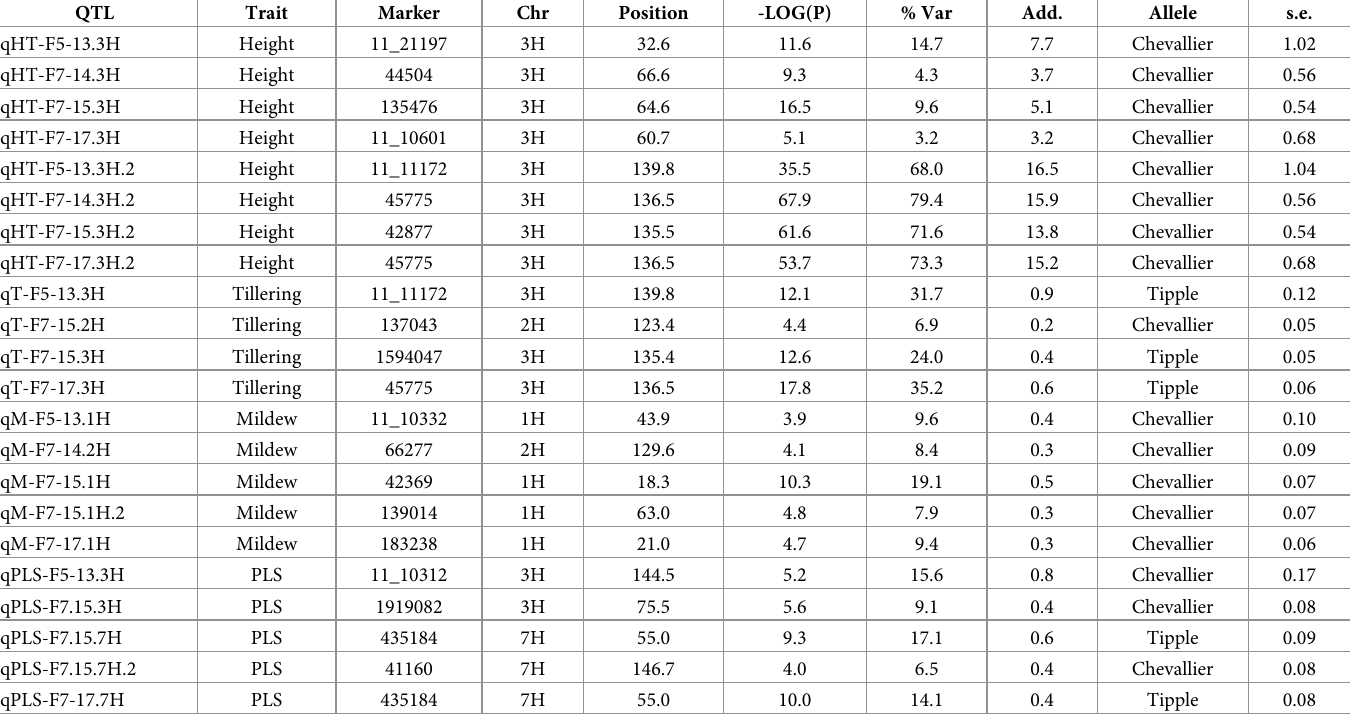
Table 2. Agronomic trait QTL identified from single-trait, single-environment QTL analysis in the Chevallier × Tipple F 5 and F 7 RILs.